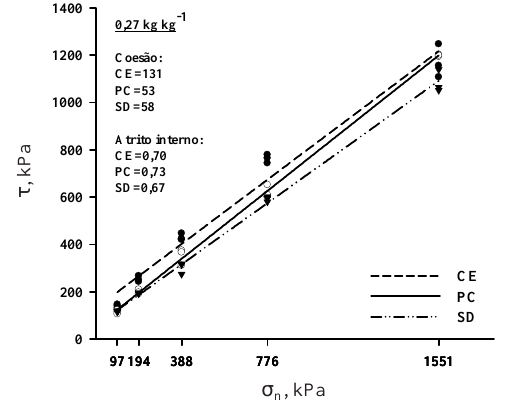
Figura 7. Relação linear simples entre a tensão normal ( σσσσσ ) e tensão cisalhante ( τττττ ) do Latossolo n Vermelho distrófico, sob cerradão (CE), preparo convencional (PC) e semeadura direta (SD), com seus respectivos parâmetros de intercepto de coesão e coeficiente de atrito, para a umidade de 0,16 kg kg -1 .